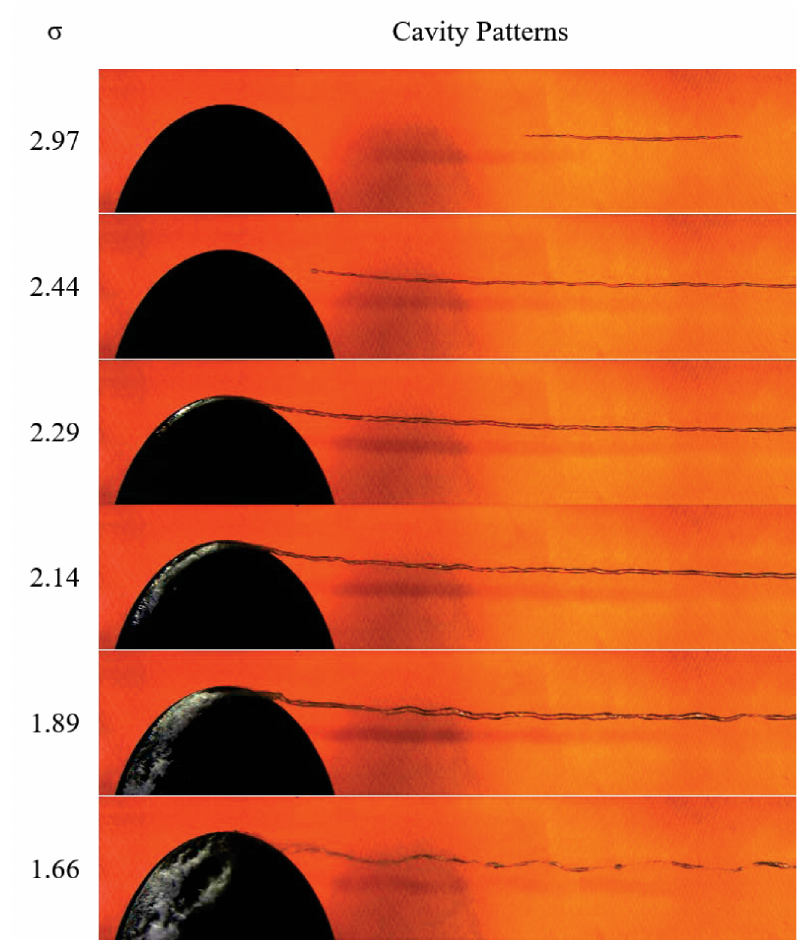
Figure 7. Cavitation pattern for NACA 16-020 hydrofoil at α = 15 ◦